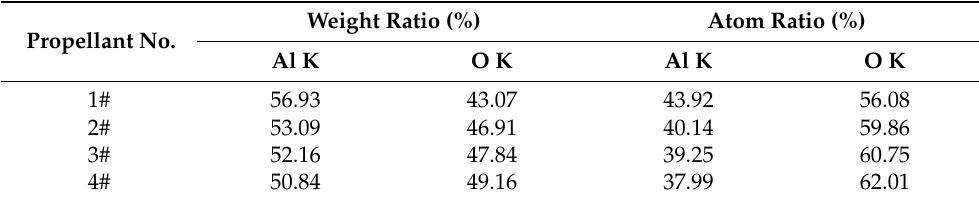
Table 3. Elemental composition of